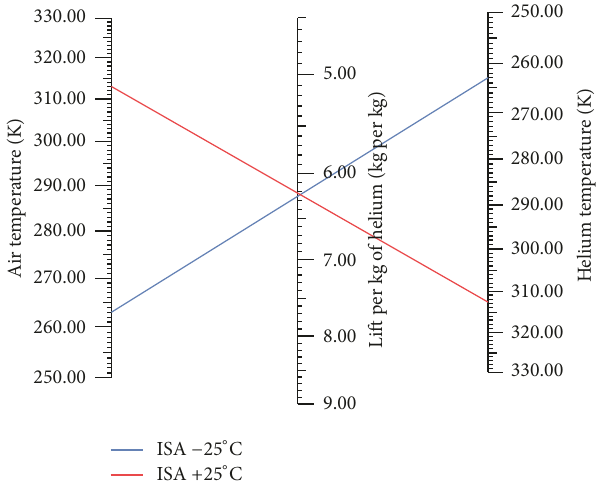
Figure 12: Relationships among design